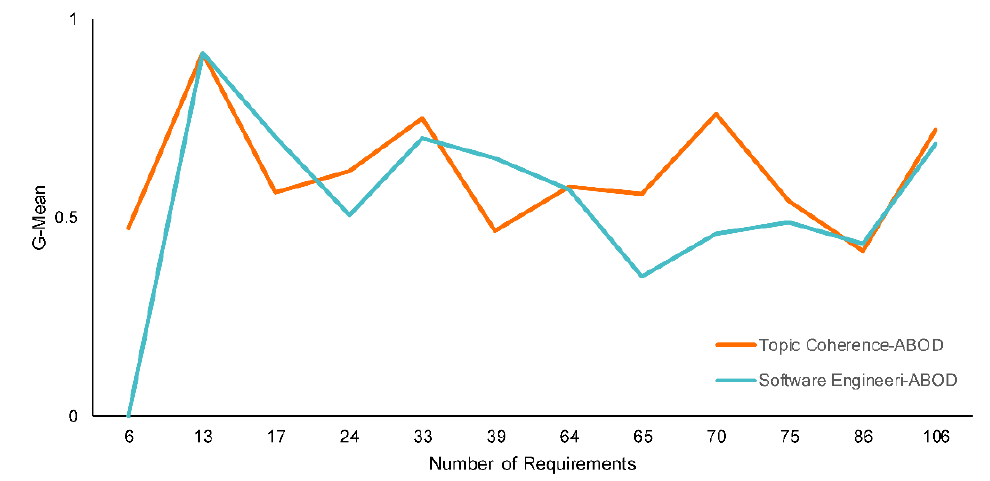
Figure 8. Performance of the two best models with respect to number of requirements in each SRS